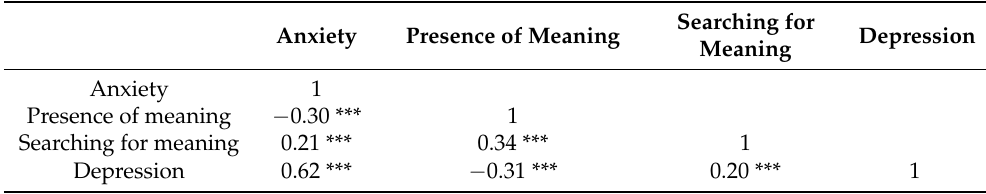
Table 2. Pearson correlation coefficients between anxiety, presence of meaning, searching for meaning, and depression ( N = 277). Searching for Depression Anxiety Presence of Meaning Meaning Anxiety 1 Presence of meaning − 0.30 *** 1 Searching for meaning 0.21 *** 0.34 *** 1 Depression 0.62 *** − 0.31 *** 0.20 *** 1